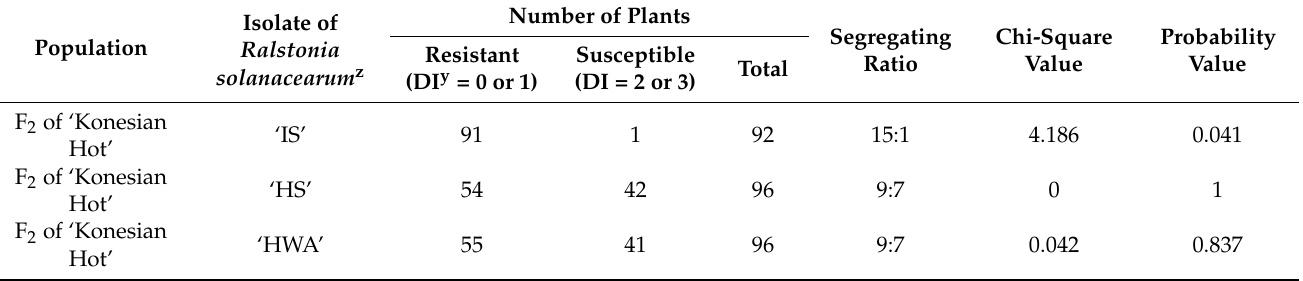
Table 1. Segregation analysis of bacterial wilt resistance in three F 2 populations of the highly